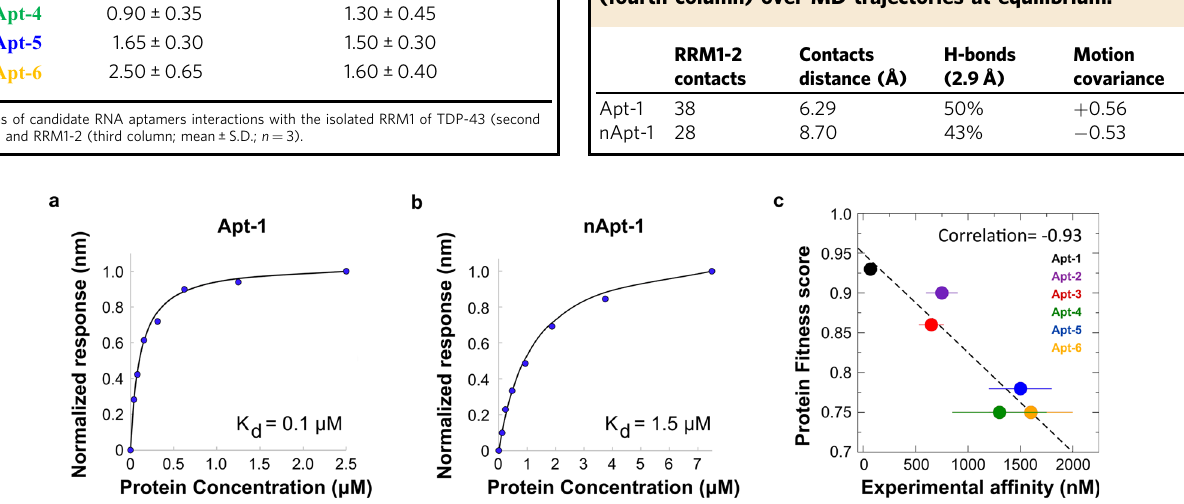
Table 2 For Apt-1 and its negative control nApt-1 we computed the RRM1-2 contact distance ( fi rst column), distance of RRM1-2 contacts (second column), fraction of H-Bonds (<2.9 Å, third column), and motion covariance (fourth column) over MD trajectories at